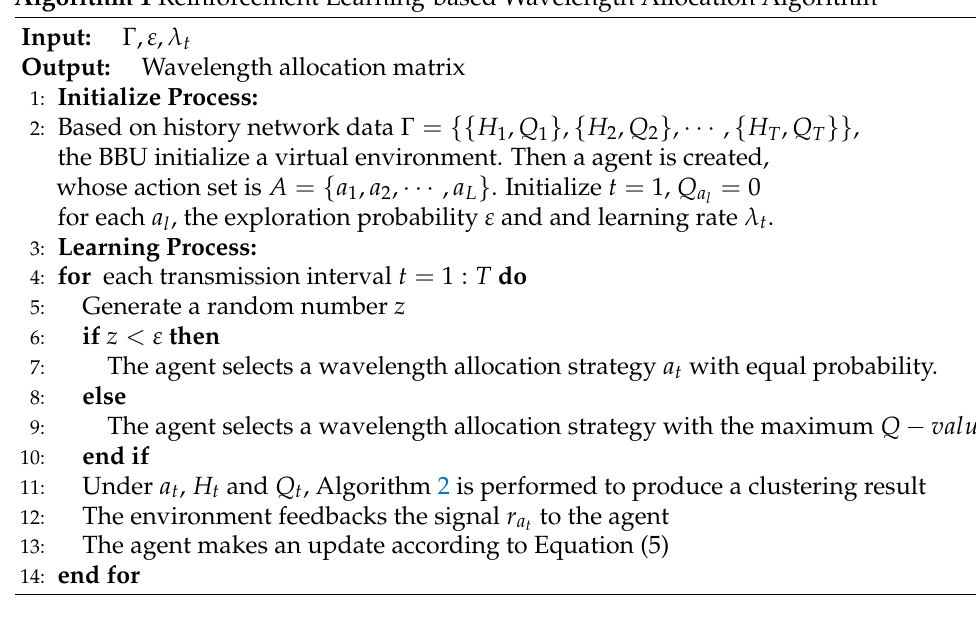
Algorithm 1 Reinforcement Learning-based Wavelength Allocation